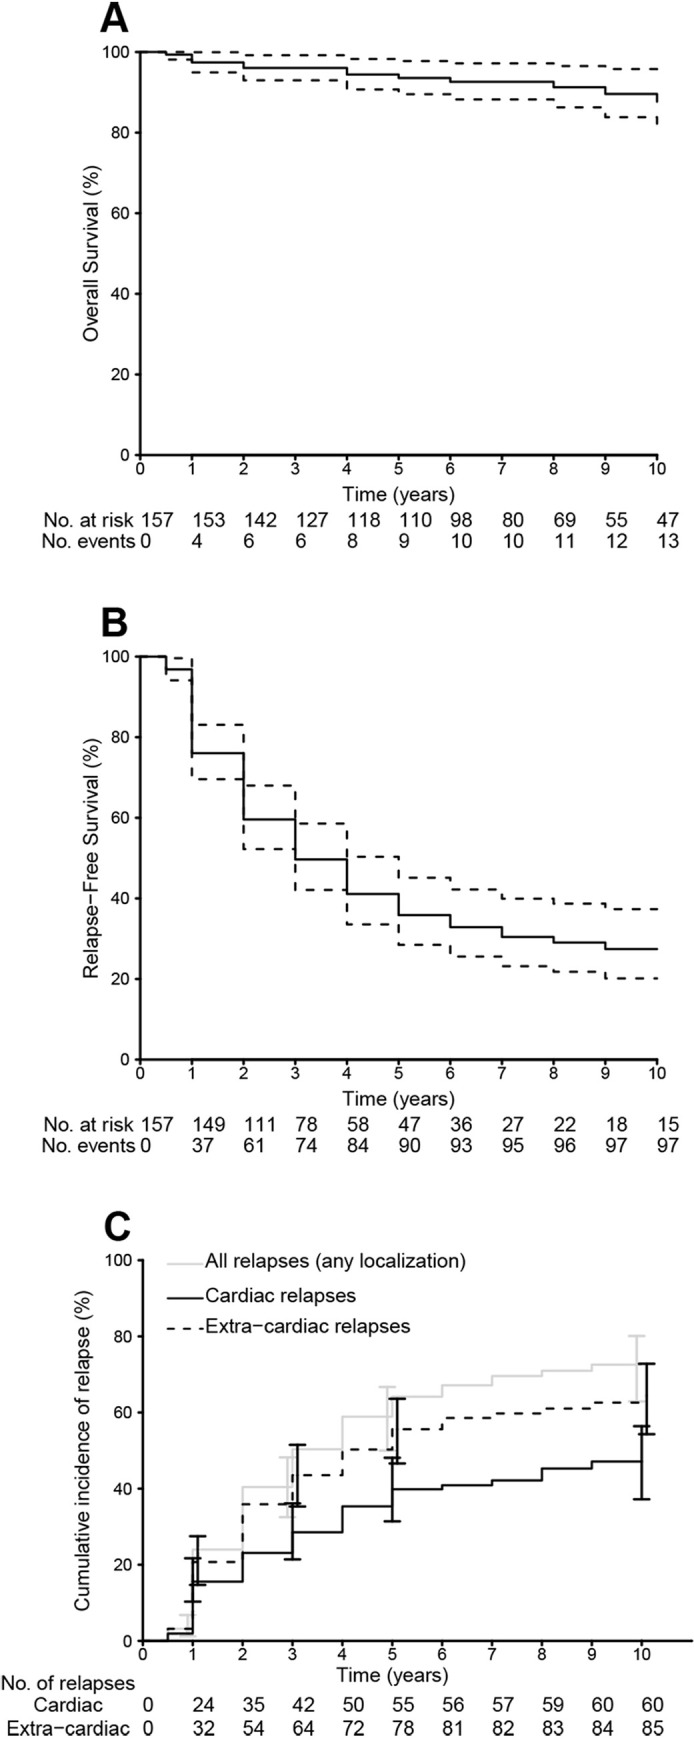
Overall survival of cardiac sarcoidosis patients (Kaplan-Meier) (panel A). Relapse-free survival for all relapses (panel B). Cumulative incidences of cardiac, extra-cardiac, and all relapses (panel C). Overall survival (OS) was defined as the time lapsed from the date of CS diagnosis to the date of death or last follow-up. Relapse-free survival (RFS) was defined as the time lapsed from the date of CS diagnosis to the date of first sarcoidosis relapse, death or last follow-up, whichever occurred first. Both cardiac and non-cardiac relapses were included for RFS analyses.